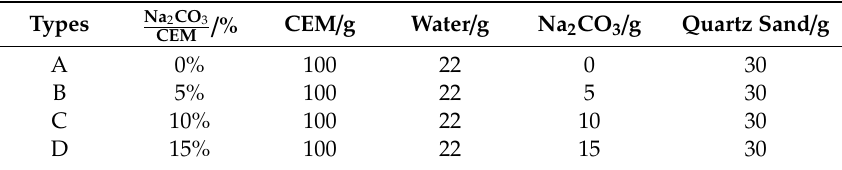
Table 2. Mix proportion of cement ‐ based healing pellets (CHPs).